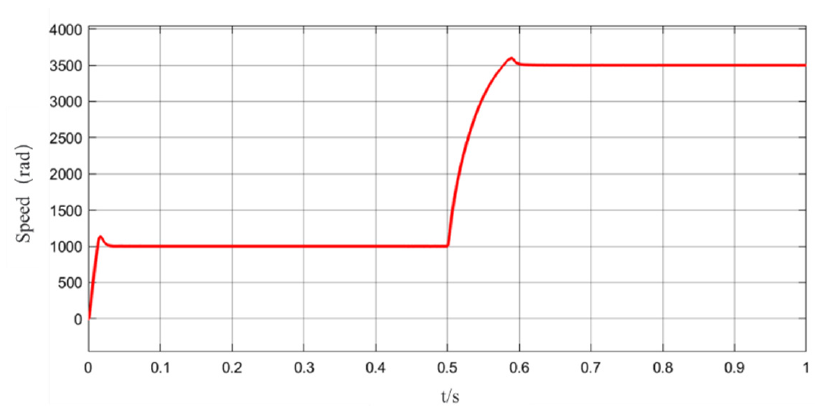
Figure 19. Speed response curve of STSM − MRAS algorithm.